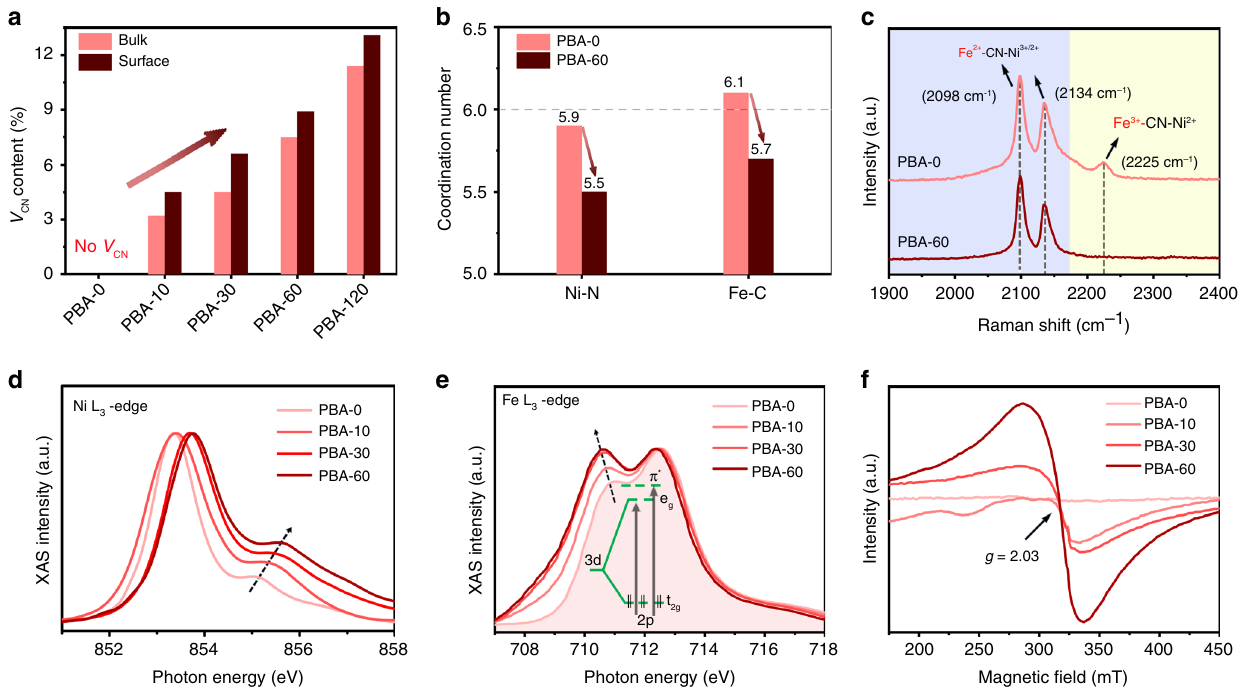
Fig. 4 Chemical and structure alterations of the V CN -mediated PBA catalysts. a The bulk and surface V CN contents of different V CN -mediated PBA catalysts. b Comparison of Ni – N and Fe – C coordination numbers for PBA-0 and PBA-60 catalysts. c Raman spectra of PBA-0 and PBA-60 catalysts. d , e Ni L 3 -edge and Fe L 3 -edge XAS spectra of PBA-0 and different V CN -mediated PBA catalysts, respectively. f ESR spectra of PBA-0 and different V CN